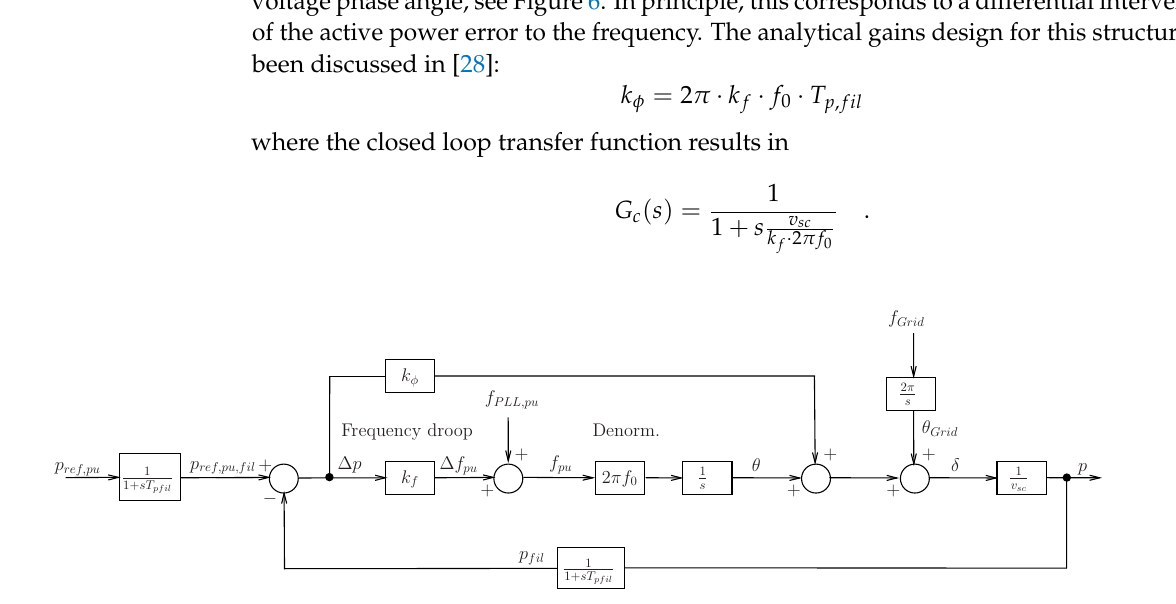
Figure 6. Enhanced Frequency control with phase intervention.